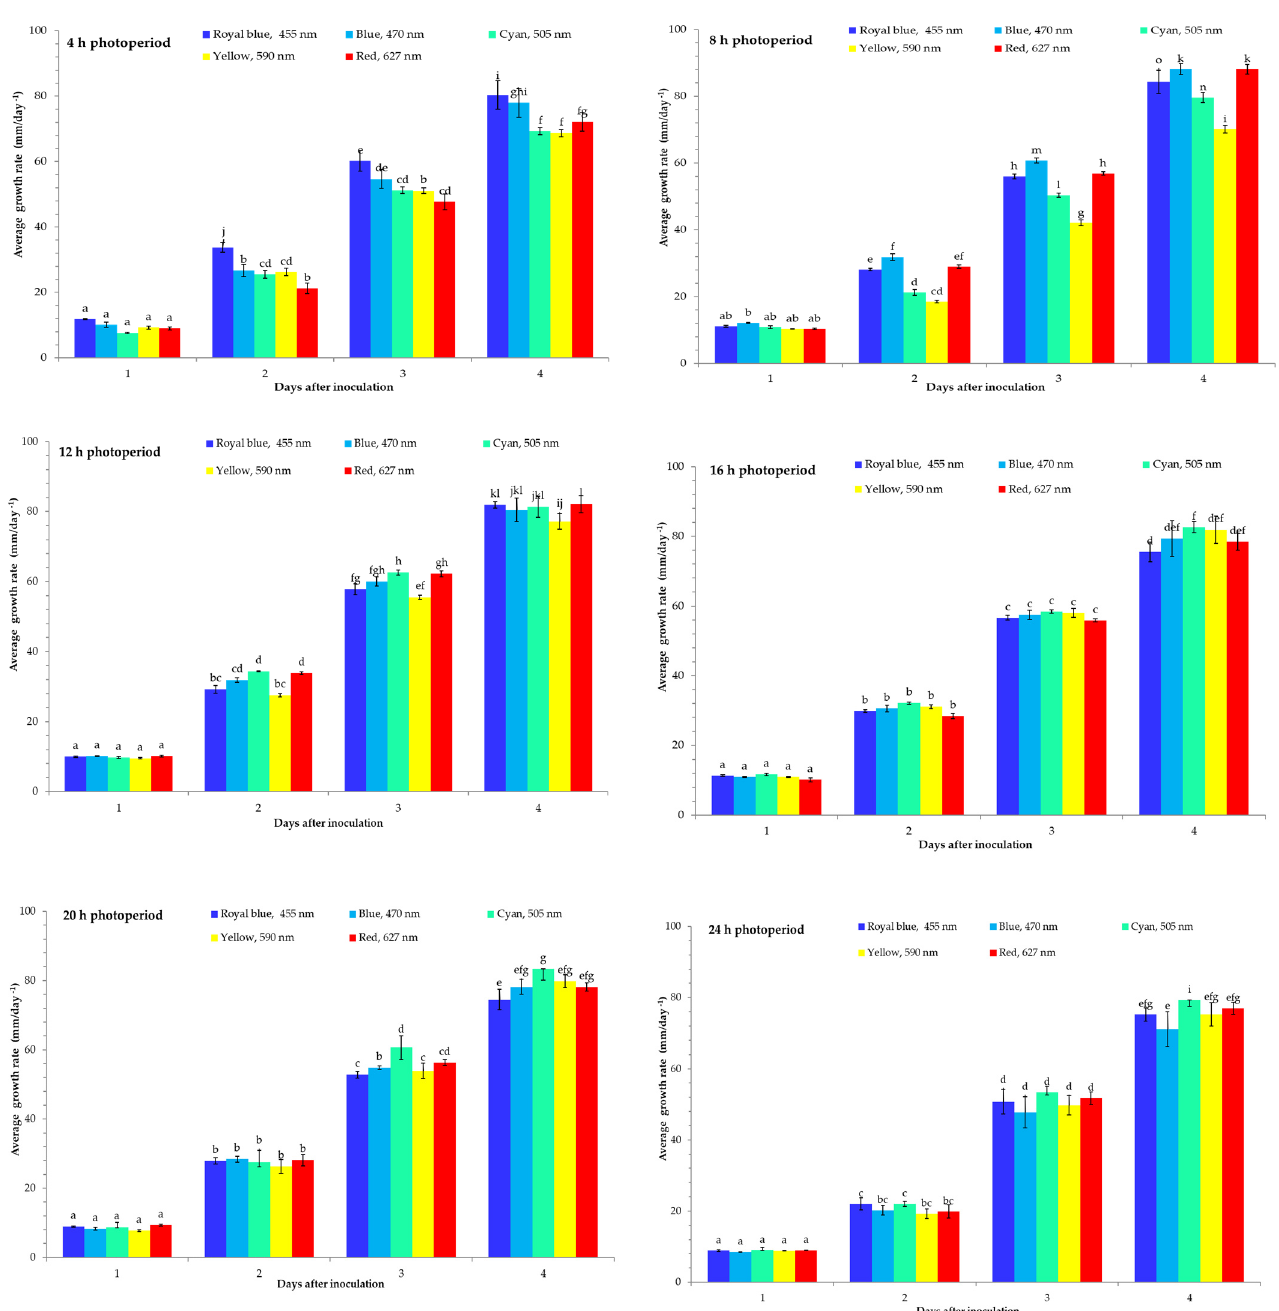
Figure 1. The average mycelium growth rate of illuminated Botrytis cinerea under 4, 8, 12, 16, 20, and 24 h photoperiods and different wavelengths. All values in the figure are expressed as mean ± standard error (n = 4). Means with different letters are significantly different at the p < 0.05 level according to Duncan’s multiple range test. Various wavelengths slightly reduced the mycelial growth curve (AUMGC) of the B.